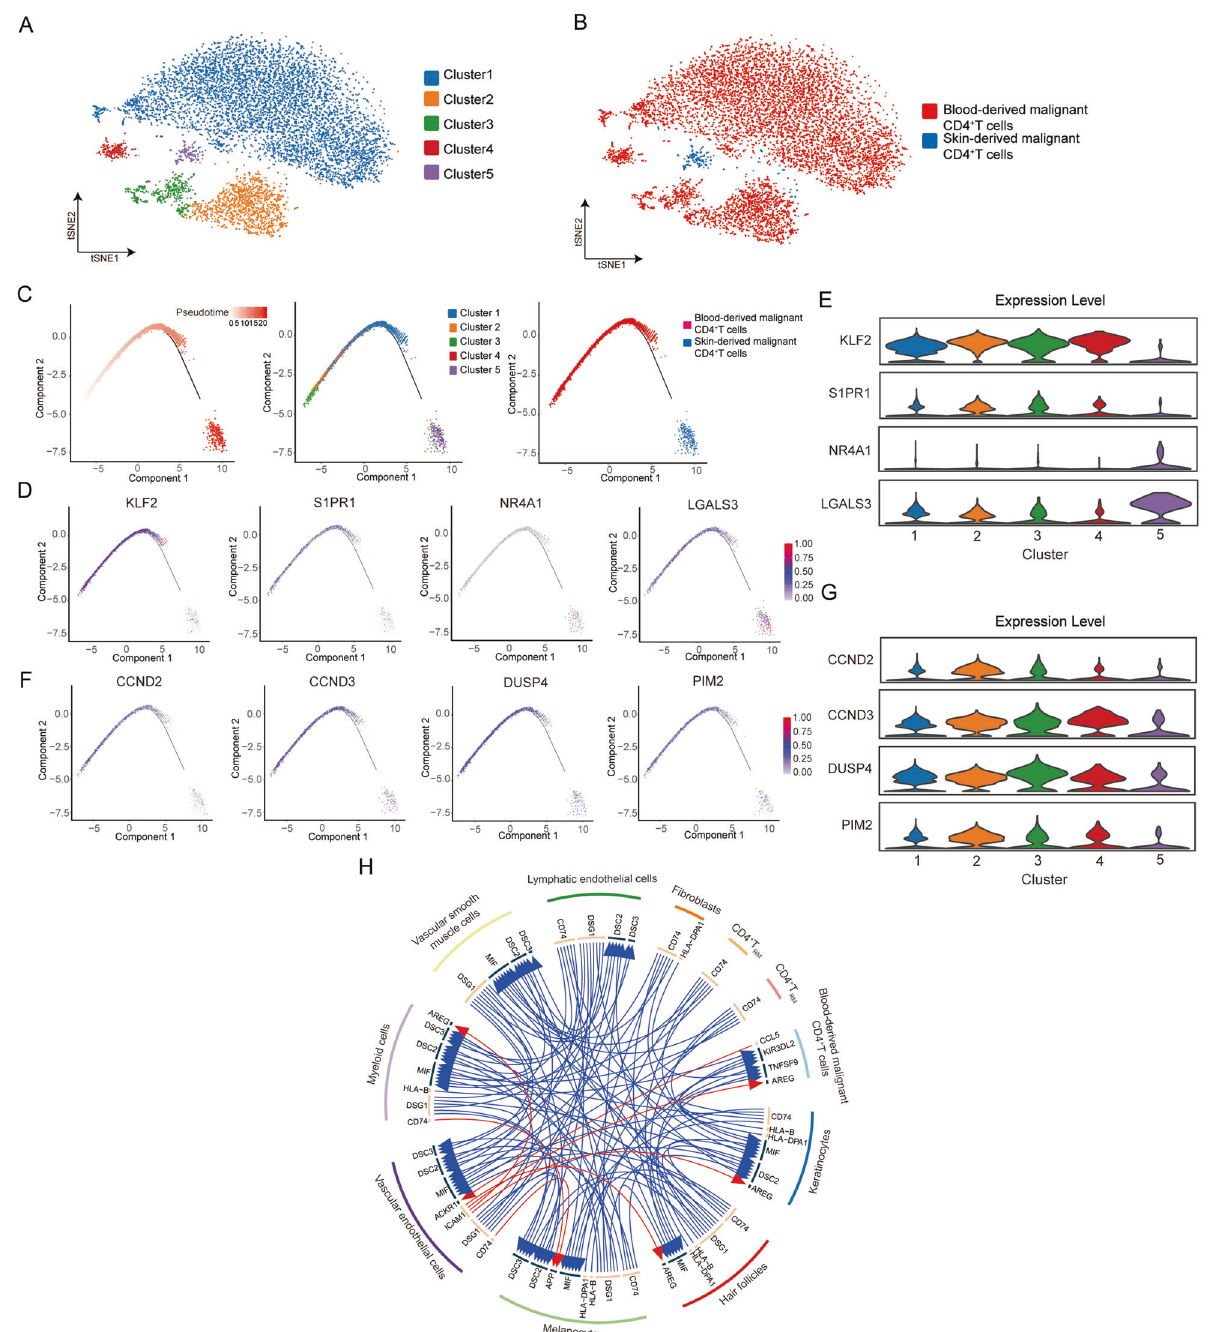
Fig. 3 Transcriptional heterogeneity between blood- and skin-derived SCs. A t-SNE visualization of scRNA-seq data from blood- and skin- derived malignant CD4 + T cells in the SS patient. B The proportions of different compartments in fi ve clusters. C Pseudotime trajectory of blood- and skin-derived malignant CD4 + T cells was generated by Monocle 2. D Trajectory plots with the expression of respective T-cell differentiation-associated genes, highest expression in red, lowest expression in grey. E Violin plot showing the expression of respective T-cell differentiation-associated genes in each cluster. F Trajectory plots with the expression of respective cell-cycle and proliferation-associated genes, highest expression in red, lowest expression in grey. G Violin plot showing the expression of respective cell-cycle and proliferation- associated genes in each cluster. H The interactions between malignant CD4 + T cells from PBMCs and all cell subtypes from skin. The strong interactions were indicated by red arrows. of 22 MF patients indicated that overexpression of TOX , DNM3 , expression of TOX , DNM3 , KLHL42 , PGM2L1 , and SESN3 showed no and KLHL42 was negatively correlated with disease-speci fi c signi fi cant difference between advanced-stage MF and SS patients survival rate in MF (Fig. S6C-E). Collectively, TOX , DNM3 , KLHL42 , (Figs. 4G, S6A). Pearson correlation analysis demonstrated that the PGM2L1 , and SESN3 might be a common gene expression expression of these genes was positively correlated with the signature in malignant CD4 + T cells from advanced-stage MF/SS, disease stage of MF/SS (Fig. 4H). Moreover, Kaplan-Meier analysis Cell Death and Disease (2022)